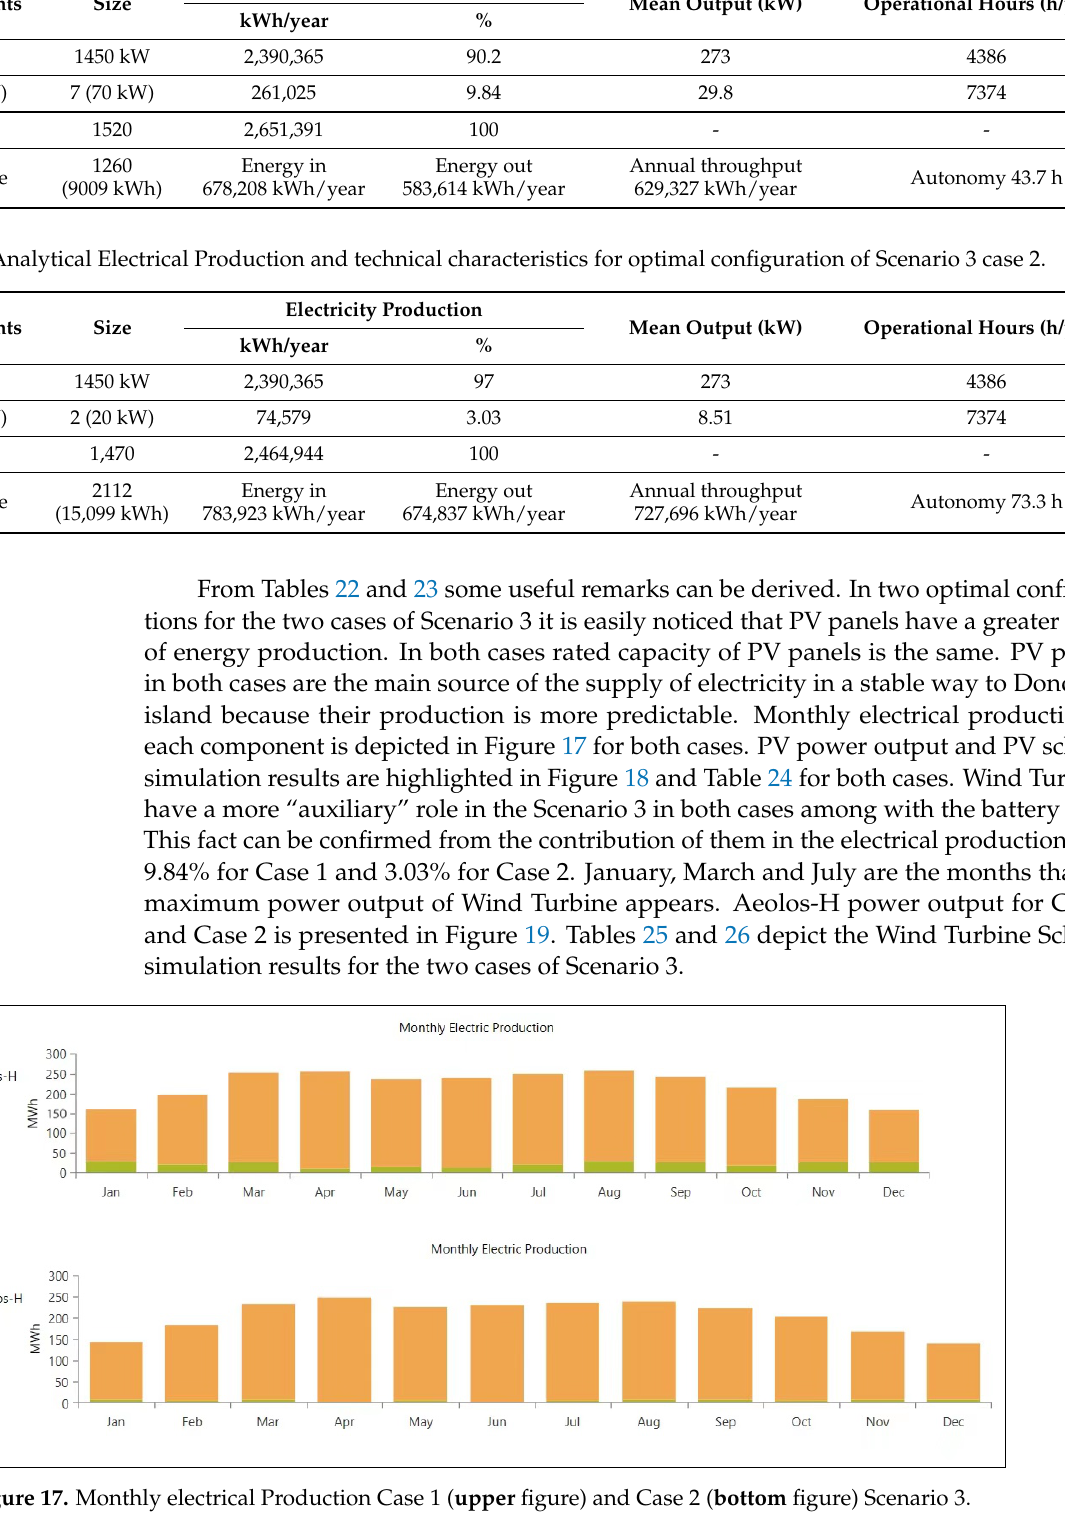
Figure 17. Monthly electrical Production Case 1 ( upper figure) and Case 2 ( bottom figure) Scenario